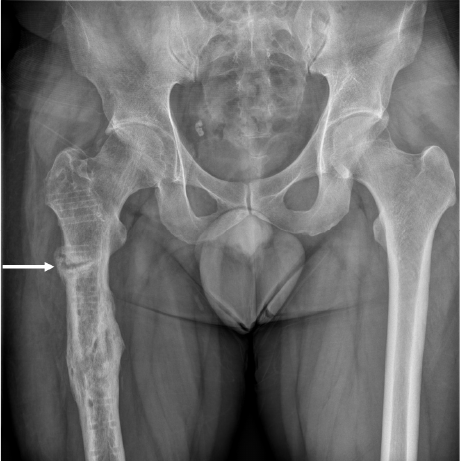
Figure 2. Conventional radiography was performed 4 months after the final operation. The white arrow indicates an incomplete transverse fracture in the lateral cortex of the right femur.